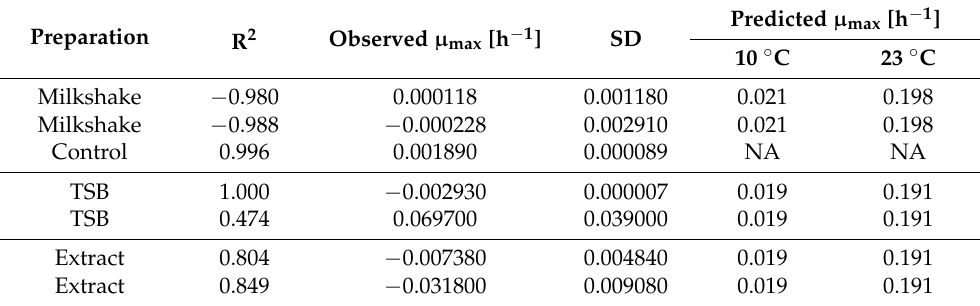
Table A4. Observed and predicted values of maximum growth rate for samples of goji berry milk- shake, extract, and TSB medium in temperature profile I.